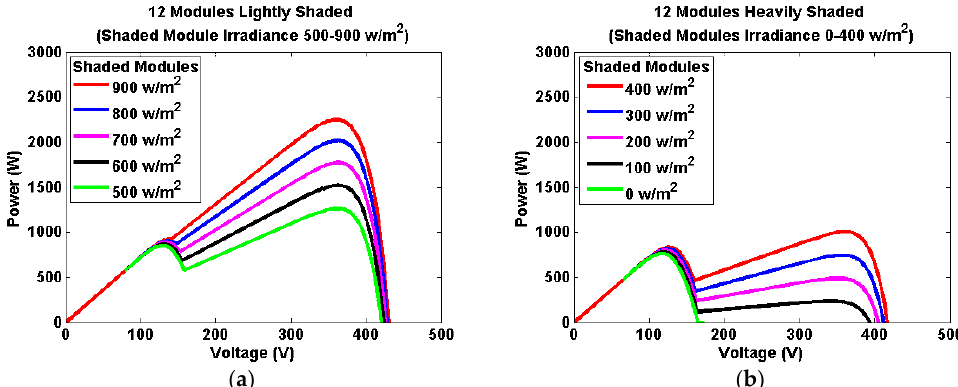
Figure 10. P-V characteristics of the 12 modules shaded setups: ( a ) shaded modules irradiance is between 500 and 900 w/m 2 ; ( b ) shaded modules irradiance is between 0 and 400 w/m 2 .